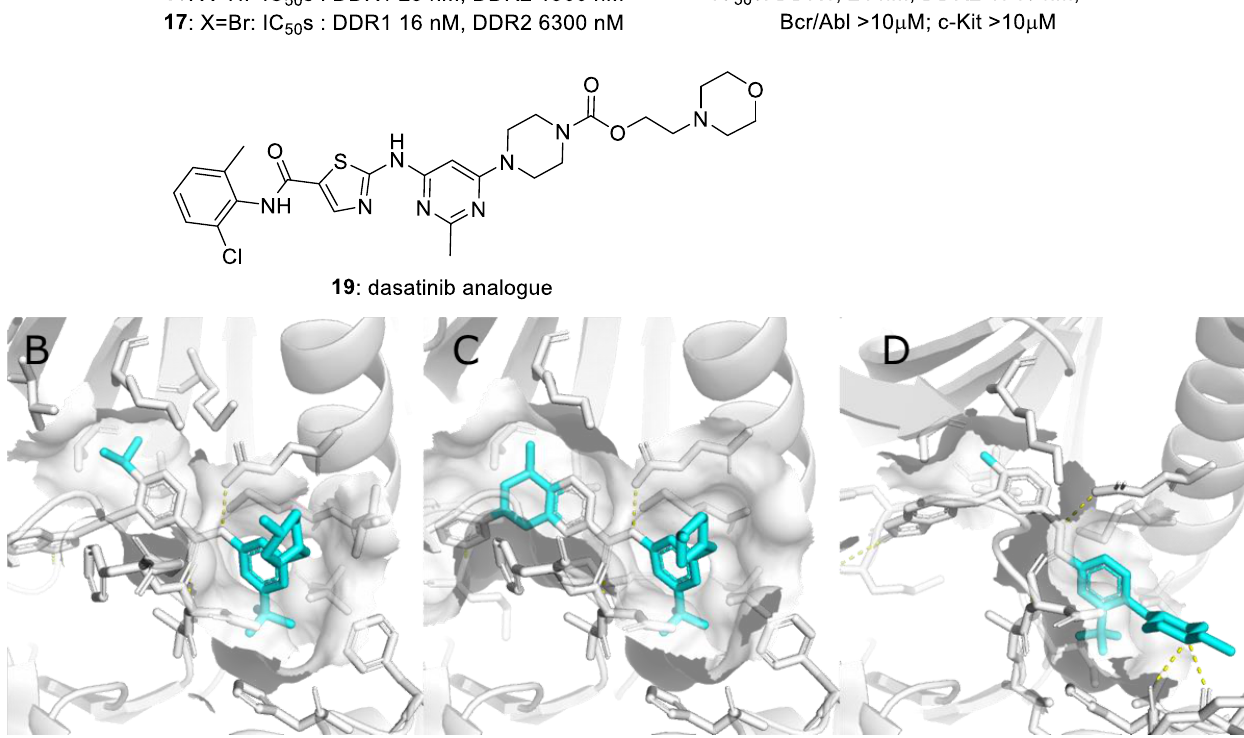
Figure 3. ( A ) Selective DDR inhibitors. ( B – D ) Hydrophobic back pocket and selectivity pockets targeted by some selective compounds 8 – 10 (PBD entries 6GRW, 5FDP and 4CKR, respectively) (image created with PyMol). Nishiota et al. [28] reported a series of hydantoin-type compounds (e.g., 20 and 21 ) that were very potent inhibitors of DDR1 (IC 50 s 1 and 3 nM, respectively), with suggested utility in cancer, kidney disease, or fibrosis. Using a fluorescence assay, Richters et al. [29] were able to distinguish between type II and III DFG-out binders for DDR2 and generated a series of potent DDR1/2 inhibitors (e.g., 22 and 23 ), with DDR2 IC 50 s of 19 and 3 nM, respectively. Xu et al. [30] used a quantitative proteomics approach to identify the major target of the tetrahydroisoquinoline-based compound 24 (DR) as a selective DDR1 inhib- itor (IC 50 21 nM) with cathepsin D as a major off-target protein in cancer cells (Figure 4). Figure 4. Selective DDR1 inhibitors.